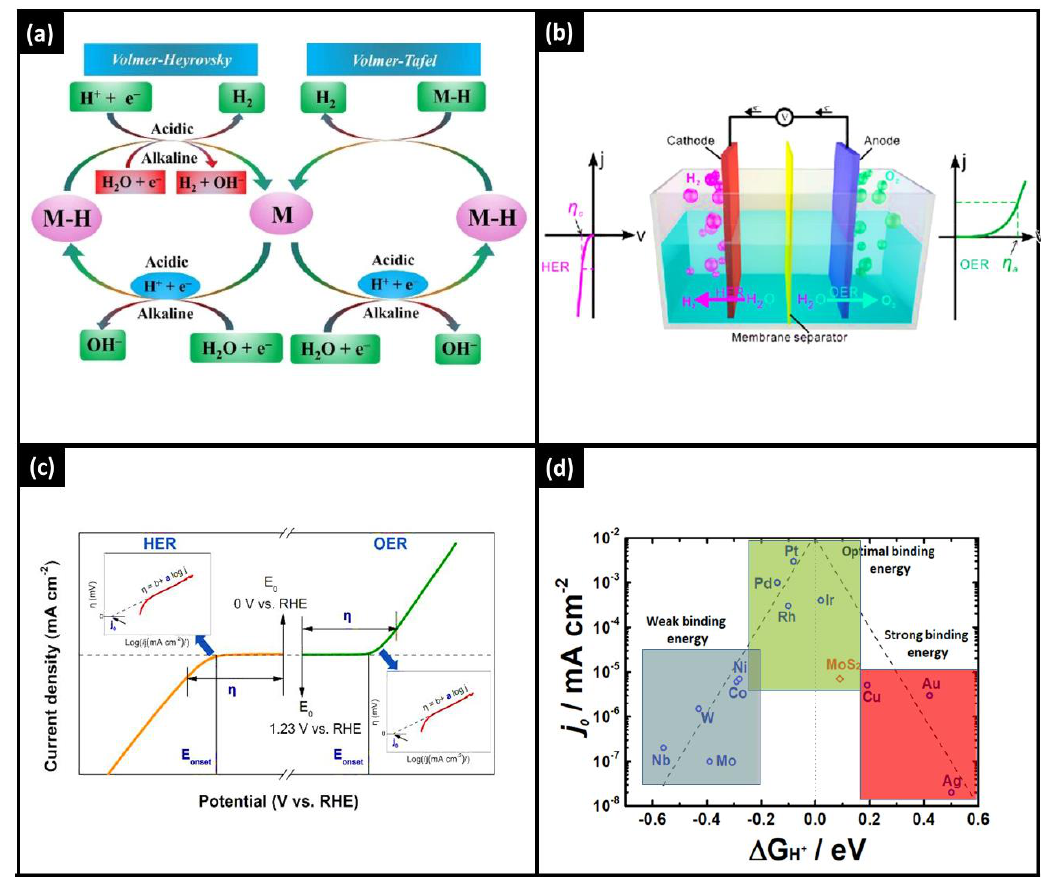
Figure 3. ( a ) The Volmer, Heyrovsky and Tafel reaction mechanisms of electrochemical water splitting. ( b ) Electrocatalysis chamber with anodic and cathodic approaches. ( c ) Overall, HER and OER kinetics. ( d ) Various electrocatalysts for HER through volcanic plot.